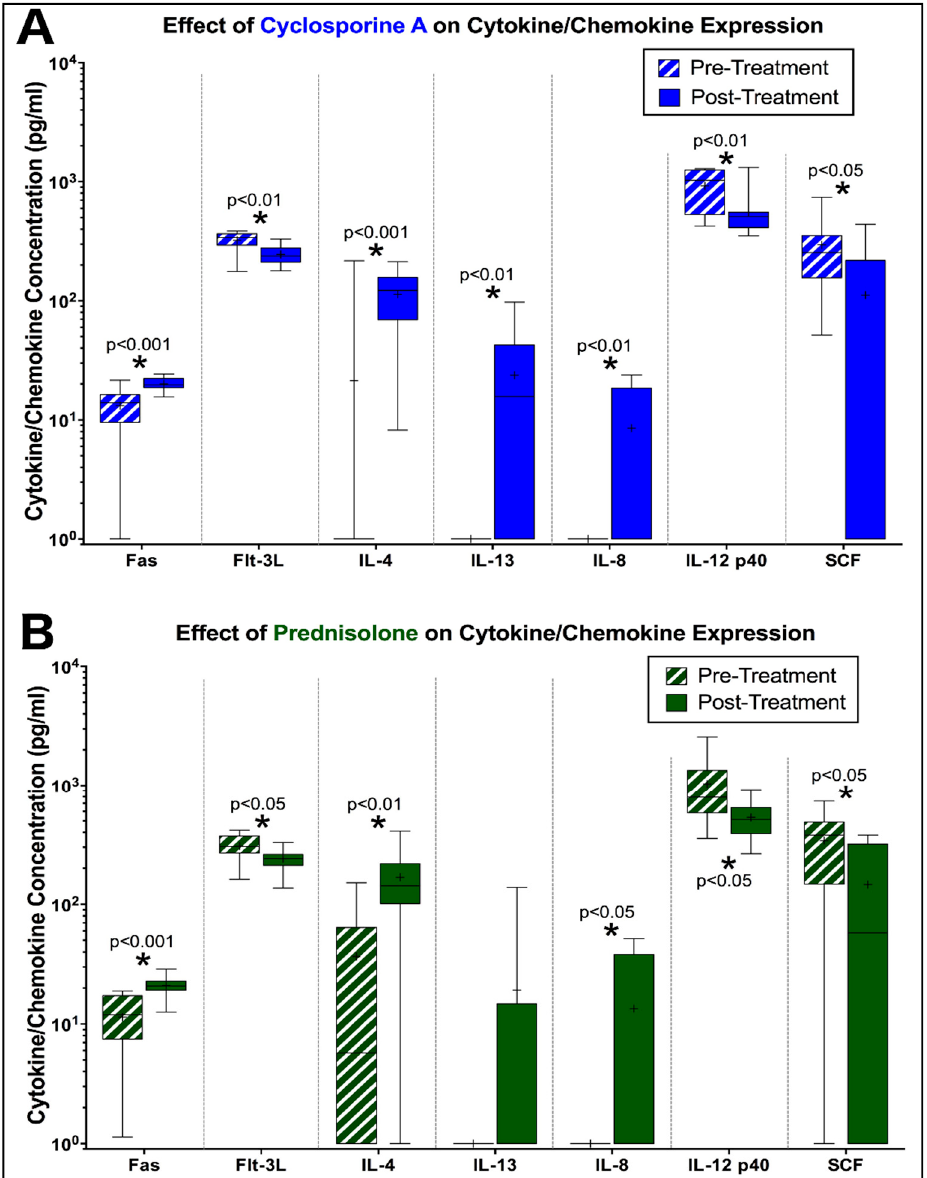
Figure 7. FIV-infected cats treated with CsA and prednisolone exhibit alterations in circulating cytokines. ( A ) FIV-infected cats exhibit increased levels of Fas, IL-4, IL-13, and IL-8 at 5 days of CsA treatment, while levels of Flt-3L, IL-12 p40, and SCF were decreased compared to pre-treatment levels. ( B ) Prednisolone-treated cats with FIV exhibit similar changes in cytokine expression (increased Fas, IL-4, IL-8 and decreased Flt-3L, IL-12 p40, SCF) at 5 days of treatment. Box and whisker plot, “+” indicates the mean for each data set.